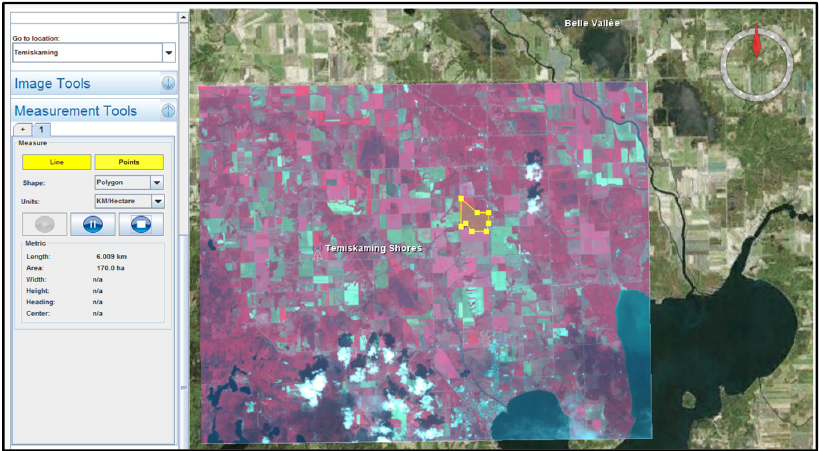
Figure 6. Example imagery overlaid atop terrain provided by the NASA World Wind framework. Tools for the imaging interface are shown at the left. The transparency tool, shown here, allows blending of several images and the underlying